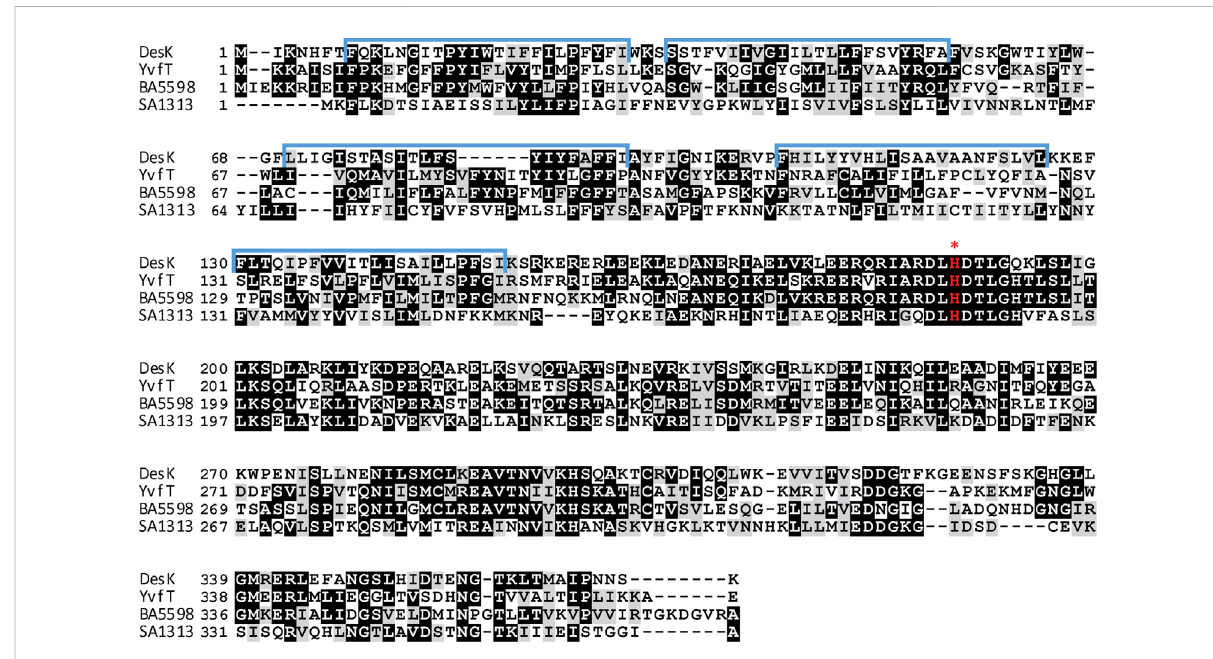
FIGURE 1 Amino acid sequence alignment of HKs, DesK, YvfT, BA5598 and SA1313. Identical amino acids are shown highlighted in black and similar ones are highlighted in gray. TMS are marked above the DesK sequence in blue (Cybulski et al., 2010). The red asterisk indicates the phosphorylatable